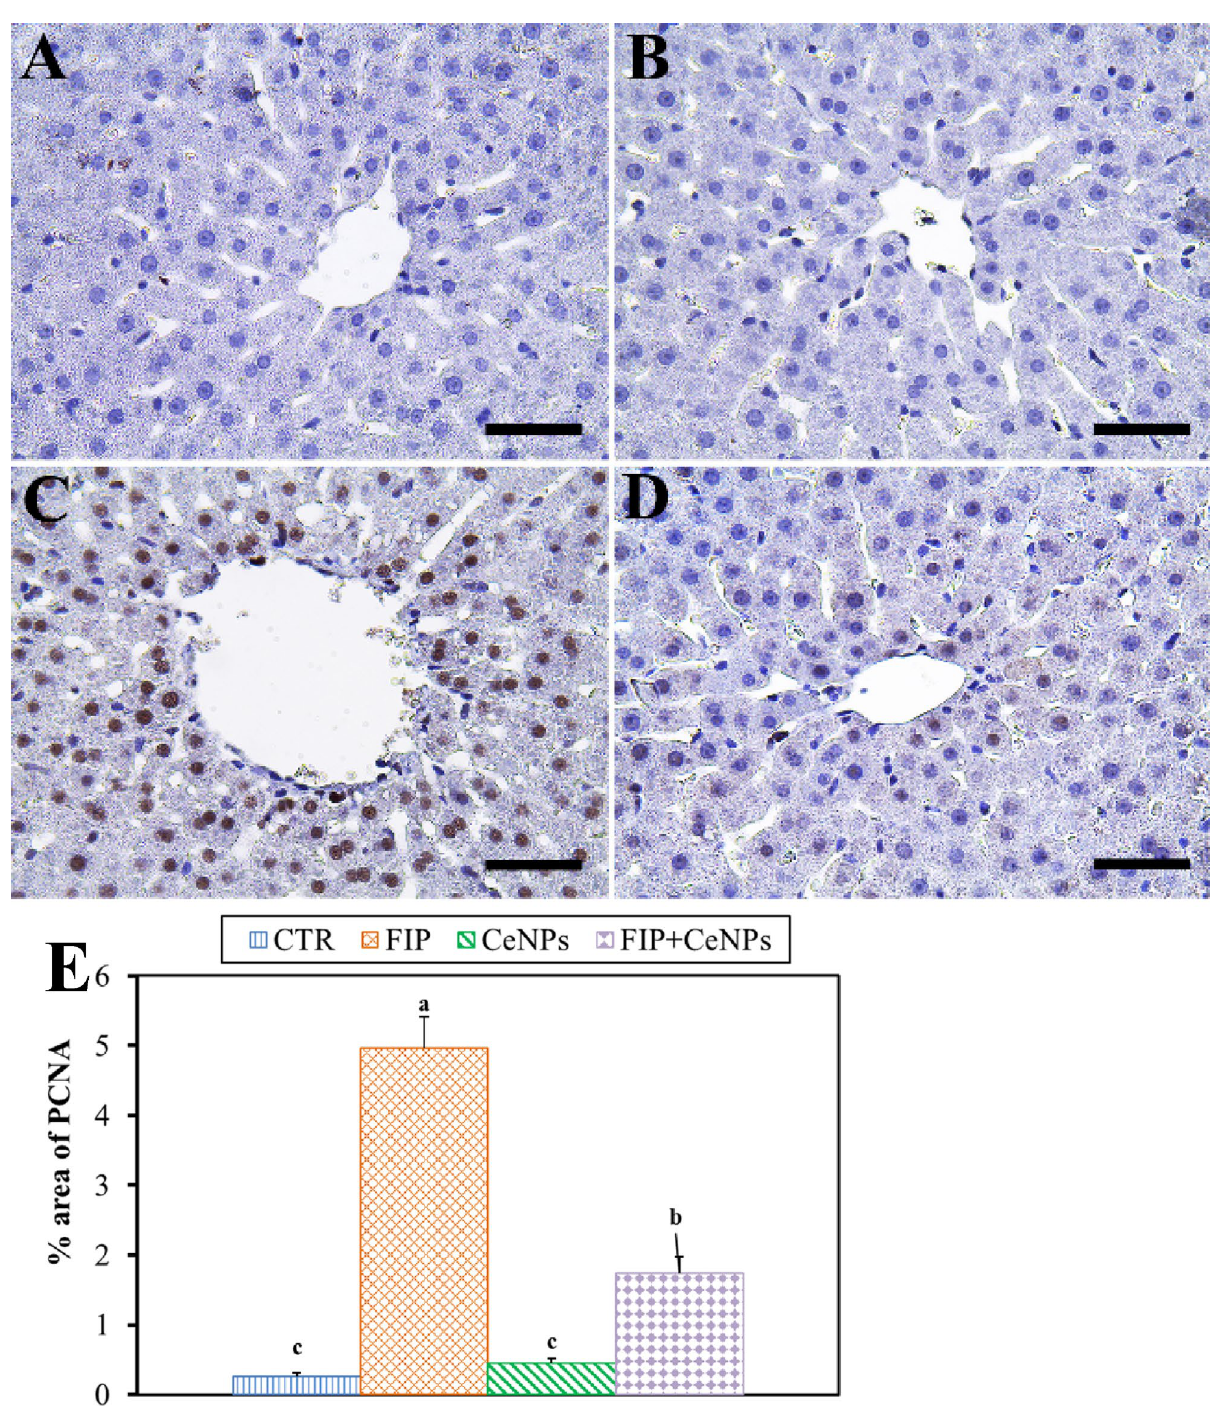
Figure 4. Immunohistochemical staining of rat liver by proliferating cell nuclear antigen (PCNA). ( A ) Negative control group. ( B ) CeNPs group. ( C ) FIP group. ( D ) FIP group that treated with CeNPs. Scale bar = 50 µm. ( E ) Quantification of PCNA in the hepatic tissues in different groups. Data expressed as Mean ± SE, analyzed using one-way ANOVA at P ≤ 0.05, column with different letters (a, b & c) indicate significant difference among the values of different